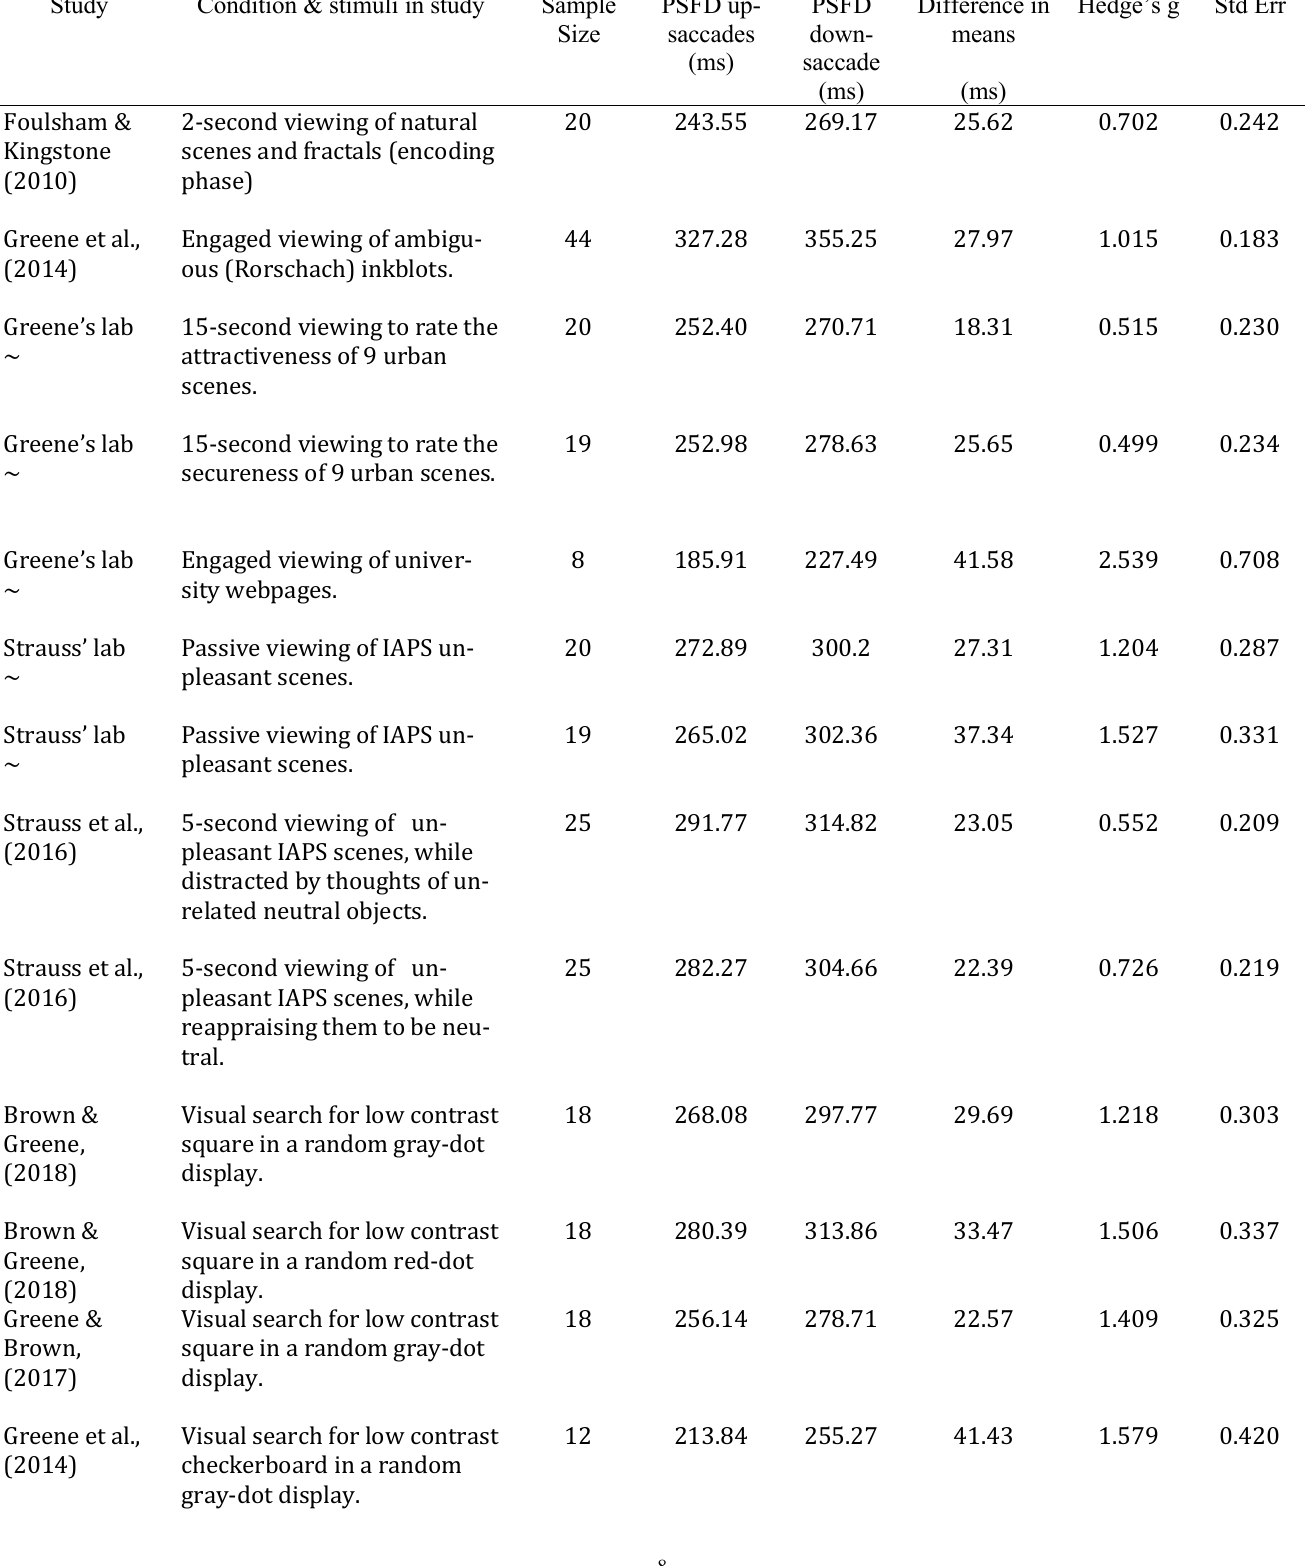
Description of tasks included in the meta-analysis. Presaccadic Fixation Durations (PSFDs) for up-directed and down-directed saccades, and effect sizes (Hedge’s g) for paired samples